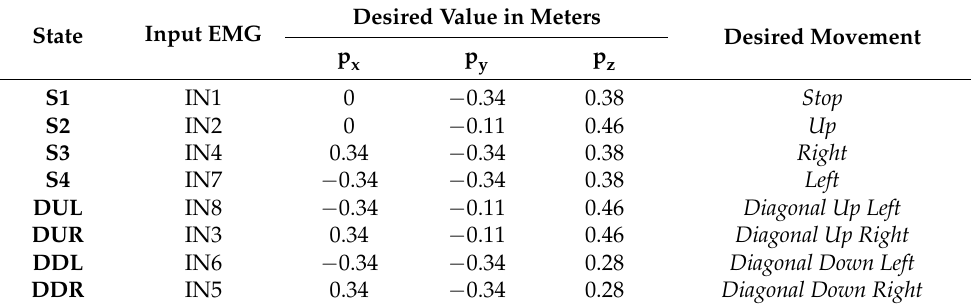
Figure 14. Eight-state Mealy-type machine, transition indicated. Table 1. Description of each of the desired positions of each